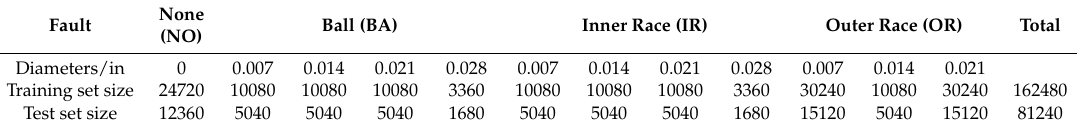
Table 3. Sizes of training and test sets in 12 conditions.